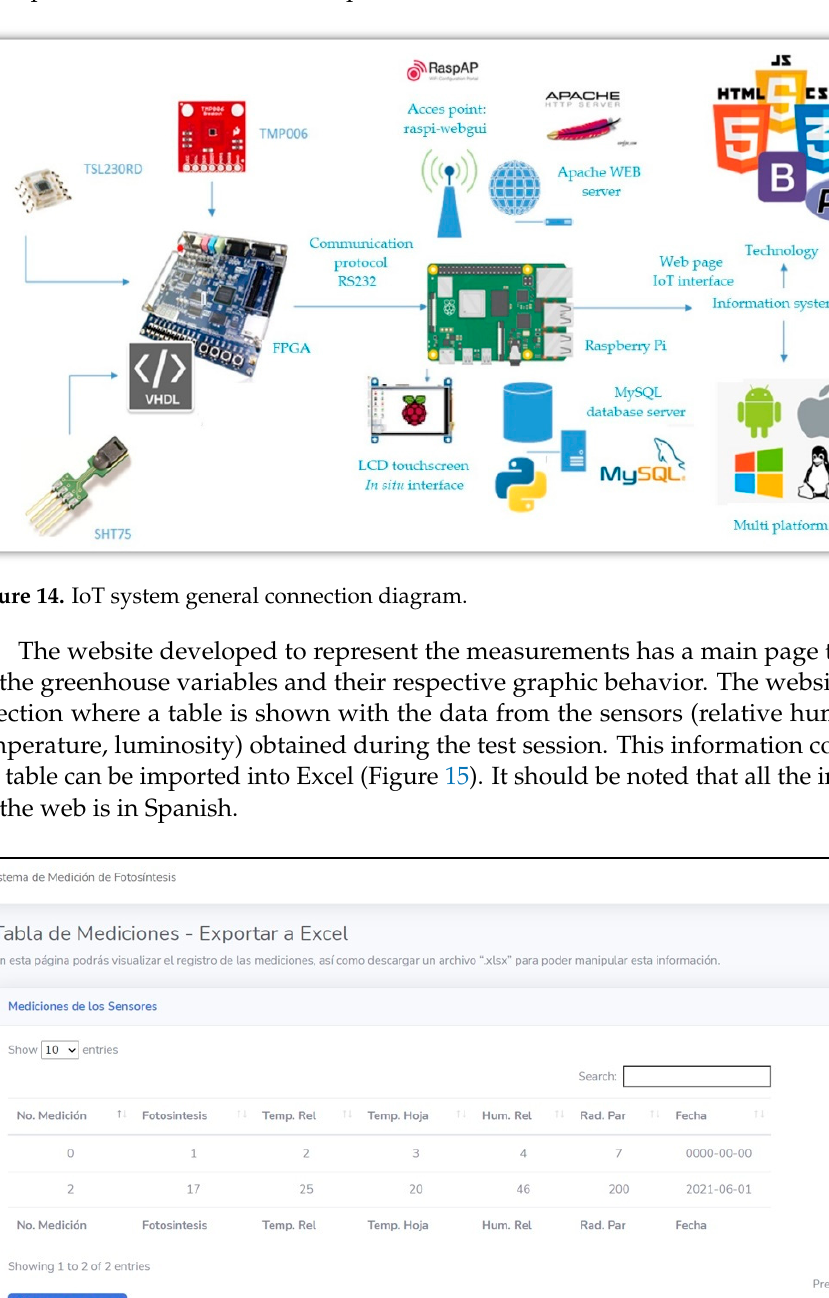
Figure 13. Complete structure of the design of the mathematical model in the FPGA. ( a ) Variable acquisition and conditioning unit, ( b ) variable processing unit (digital implementation of the black- box mathematical model), and ( c ) offset adjustment and serial transmitter unit.